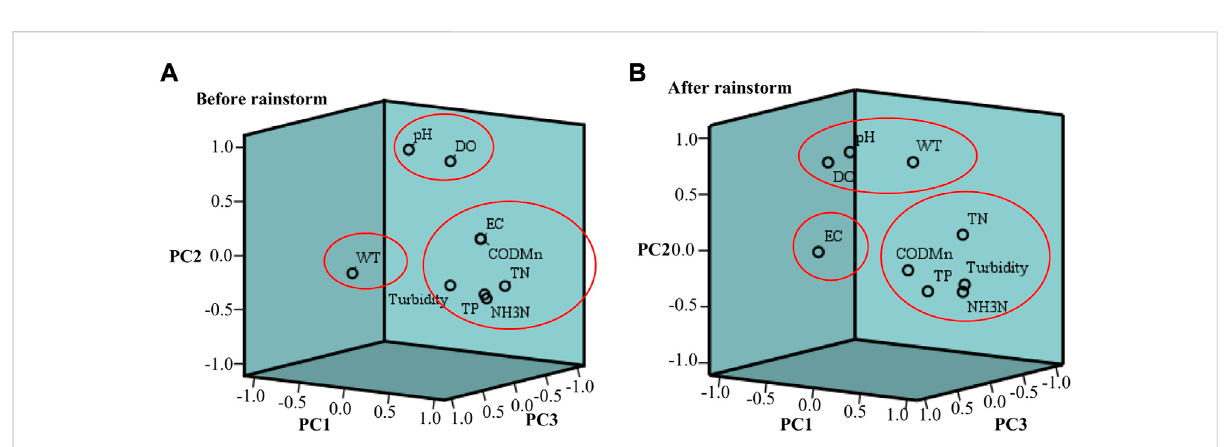
FIGURE 9 Therotationfactorloadofwaterqualityindicatorsbeforerainstorm (A) andafterrainstorm (B) intheHuaiheRiverBasin.Thesampledatapassed the test of the Kaiser-Meyer-Olkin (KMO) and Bartlett, the principal components were identi fi ed by the eigenvalues greater than